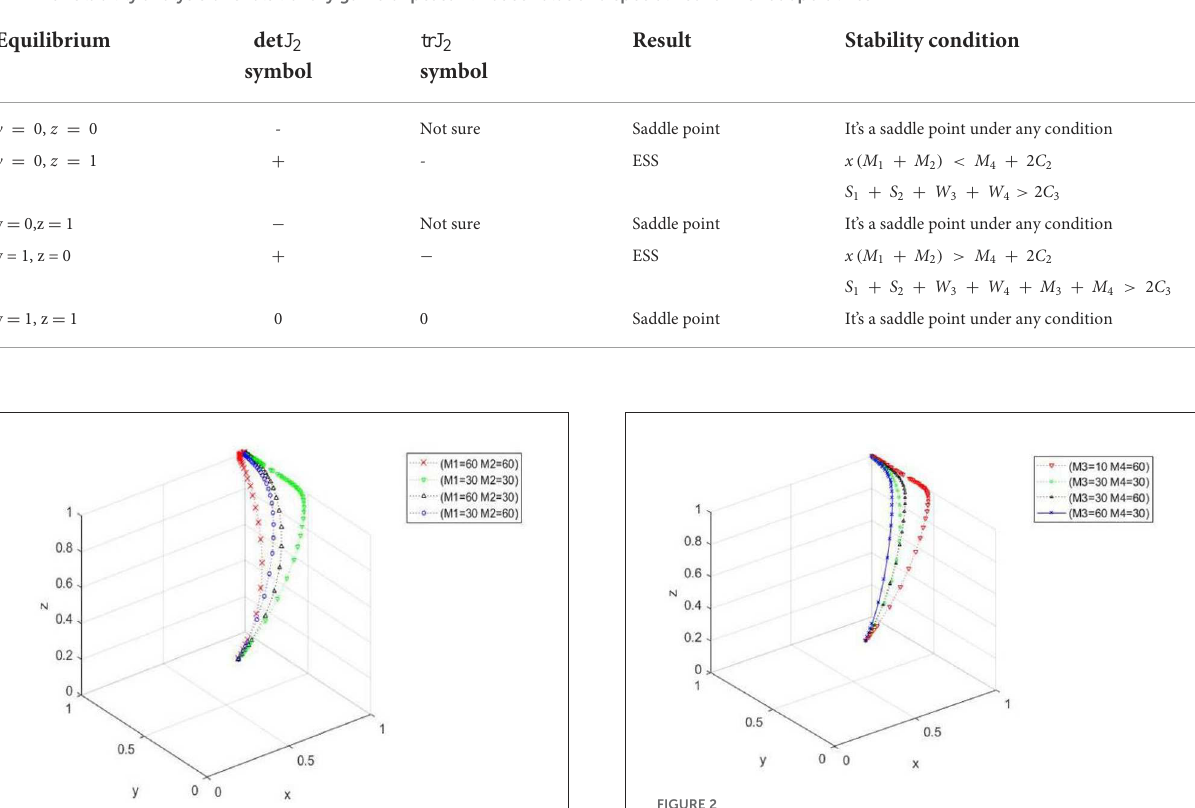
TABLE 3 Stability analysis of evolutionary game of peasant households and specialized farmer cooperatives.